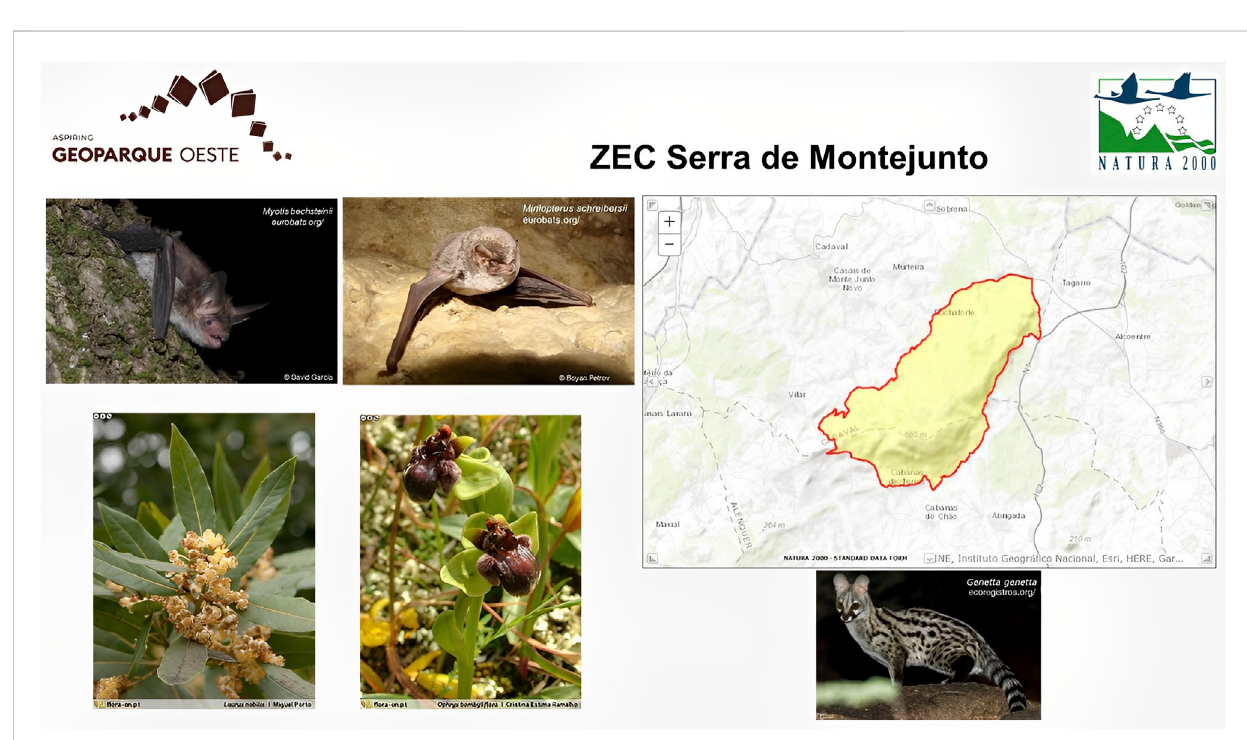
FIGURE 7 Serra de Monte Junto special conservation area. Source: produced by the